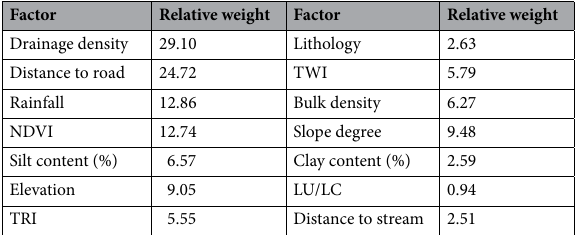
Table 3. Relative influence of effective conditioning factors in the random forest